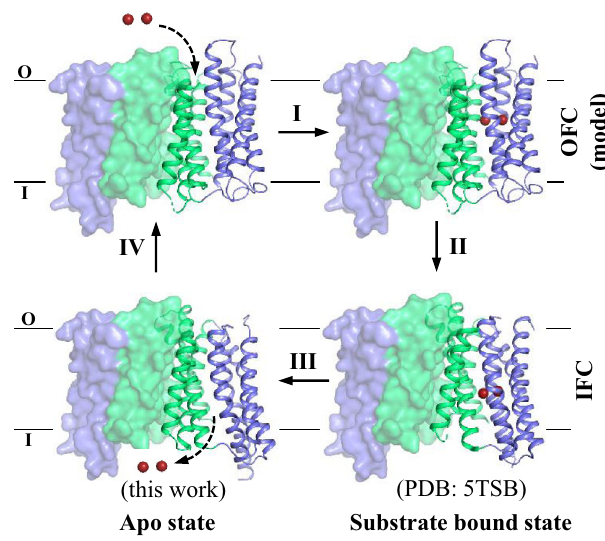
Fig. 10 | Proposed transport cycle of BbZIP. The complete transport cycle con- sists of at least four consecutive steps: I — Metal substrate(s) bind to the transport site(s) of the transporter in the OFC; II — Metal substrate binding facilitates the conformational change from the OFC to the IFC, presumably via a charge- compensation mechanism; III — Metal release from the transport site(s) causes dis- assemble of the primary transport site (M1); IV - The altered domain interface triggeredbyM1disassemblefacilitatesaconformationalswitchfromtheIFCtothe OFC. For clarity, the protomer shown in surface mode is fi xed in the IFC, and the otherprotomerin carton modeisshownin distinctconformationalstates with the scaffolddomain(DomainII)coloredingreenandthetransportdomains(DomainI) in blue. The metal ion substrates are depicted as dark red spheres. The dashed arrows indicate the directions of metal transport. During transport, the dimeric scaffold domain largely remains static, whereas the transport domain vertically slides against the scaffold domain. The OFC models were generated using repeat- swap homology modeling and validated by chemical crosslinking and cysteine accessibility assay in this work. The IFC structure with bound metal substrate is derived from the previously solved structure (PDB entry ID: 5TSB) and the IFC structure in the apo state is reported in this